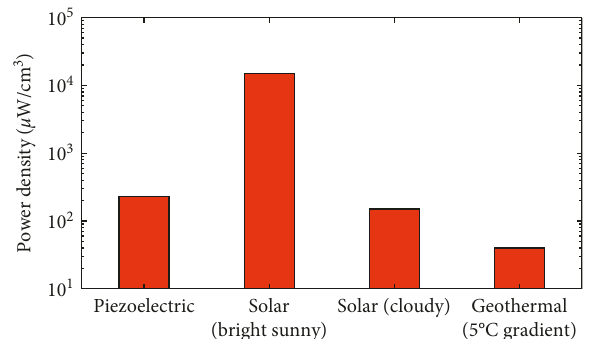
Figure 3: Power density of different green technologies (based on [13,